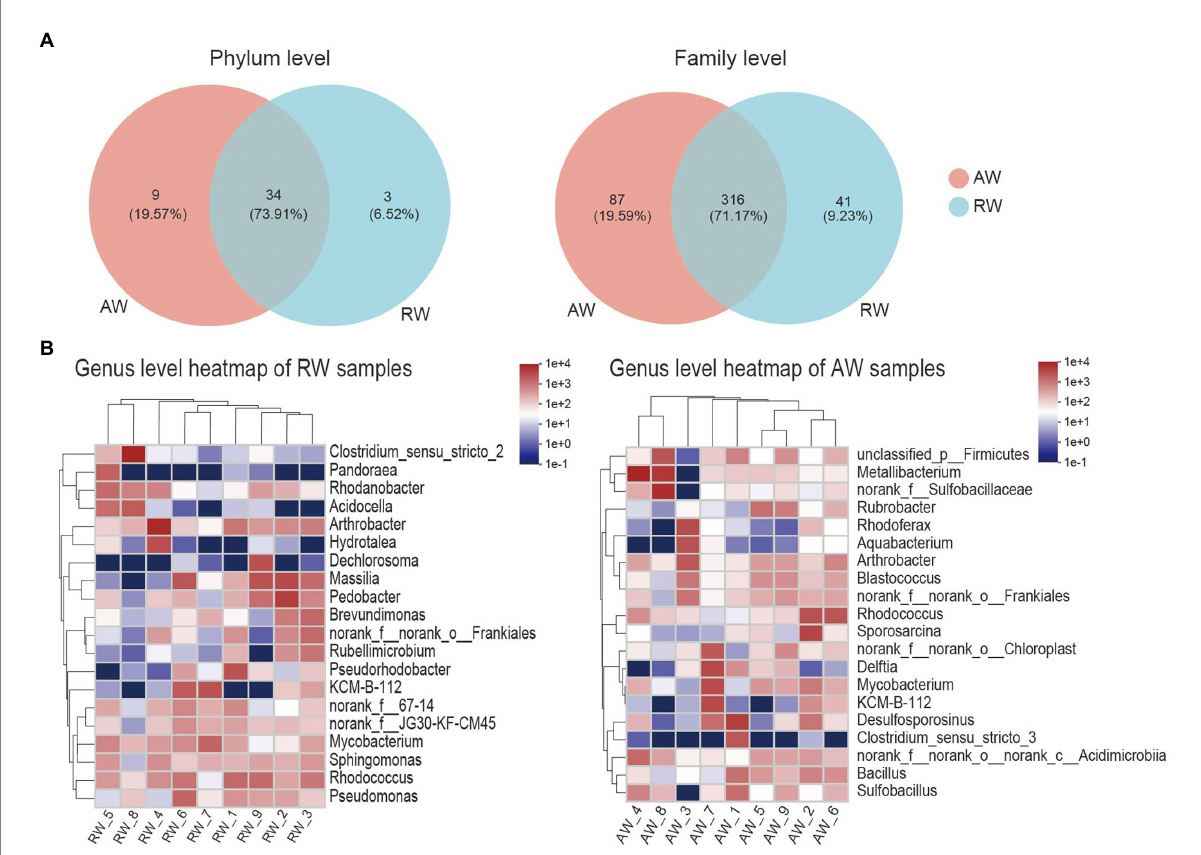
FIGURE 5 Taxa composition analysis in phylum, family and genus level. (A) Venn diagram of the microorganisms in phylum and family level, the different colors represent different groups and the numbers in the overlapping part represent the number of taxa shared by two groups, and the numbers in the non-overlapping part represent the number of taxa unique to the corresponding group. (B) Heatmap of the top 20 families of relative abundance at genus